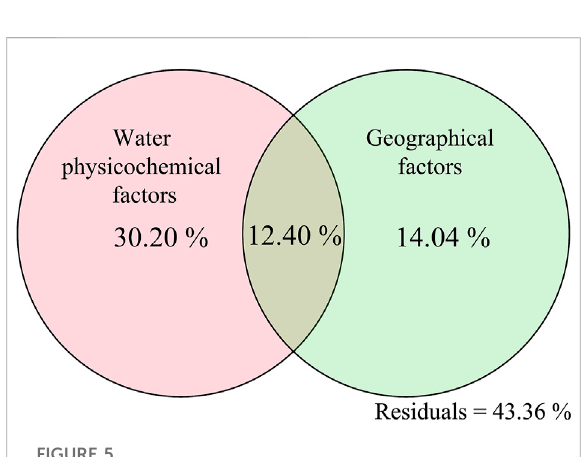
FIGURE 5 Variation partition analysis (VPA) diagram of geographical factorsandwaterphysicochemicalfactorsindeterminingbacterial composition